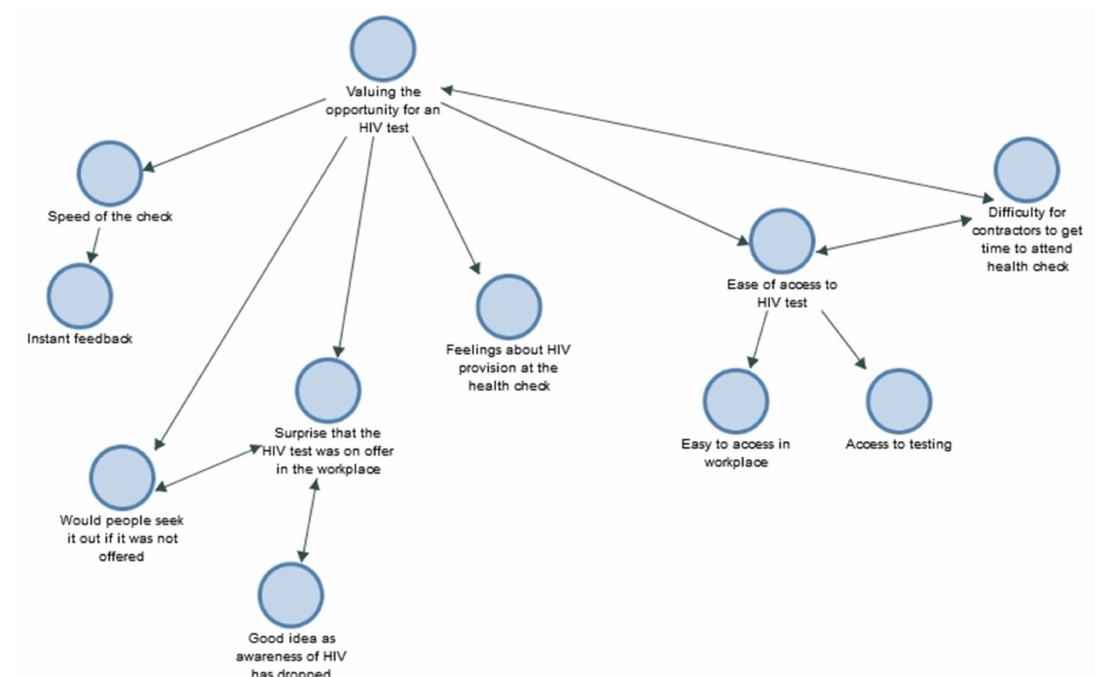
Figure 1. Theme (a): Valuing the opportunity for an HIV test.